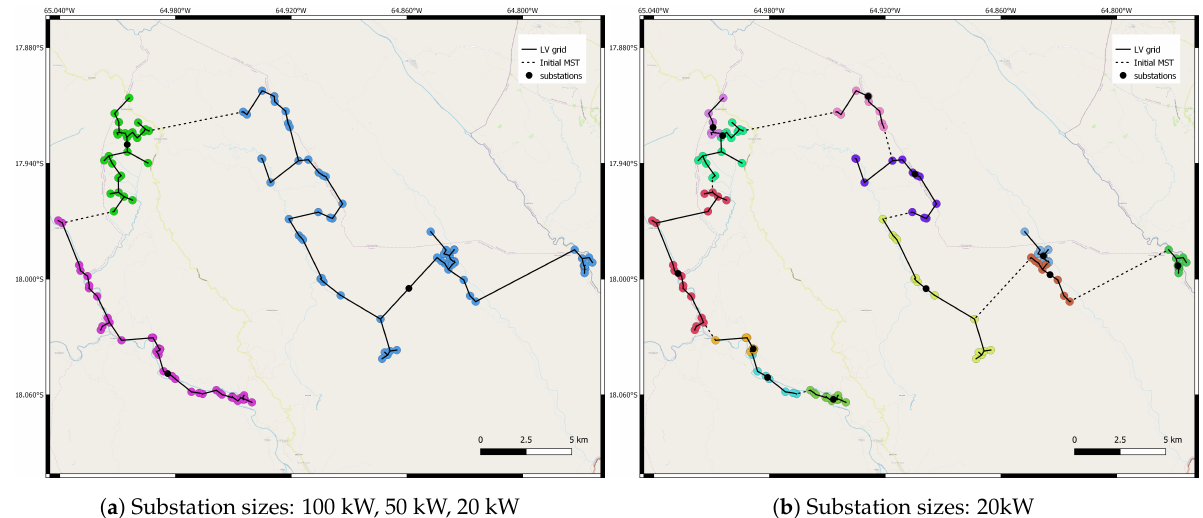
Figure 9. Results of Lukes clustering procedure in